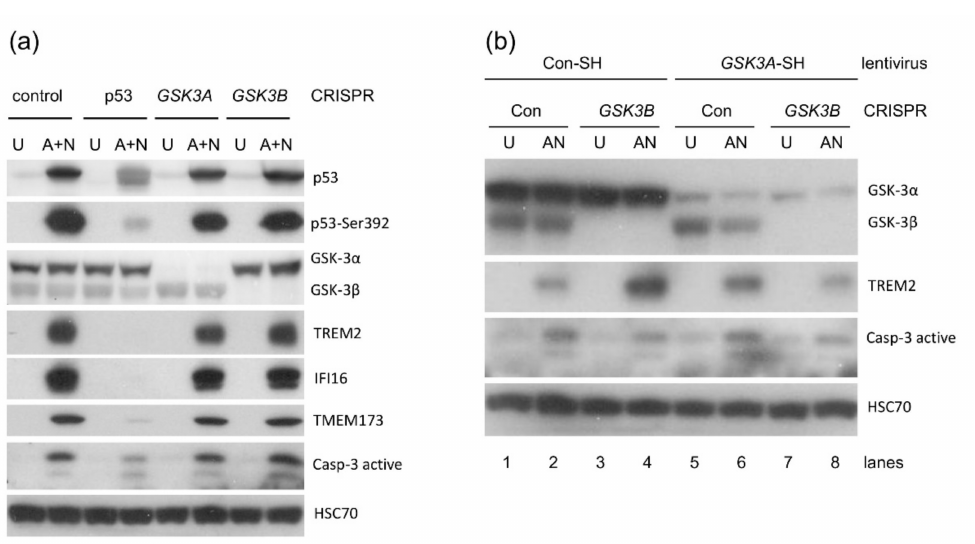
Figure 9. Downregulation of GSK-3 does not mimic the effect of CHIR-98014 on TREM2 expression or caspase-3 activation. ( a ) The expression of selected proteins in cells with the expression of either GSK-3 α , GSK-3 β or p53 downregulated by CRISPR/Cas9 technology. Control cells for knockdown were also used. The cells were either mock-treated (U) or exposed to A + N for 48 h. ( b ) Expression of TREM2 and active caspase-3 in cells with double knockdown of GSK3A and GSK3B . The cells with GSK3B expression knocked-down by CRISPR/Cas9 technology or the controls for knockdown were transduced either with lentivirus producing the shRNAs directed against GSK3A mRNA or with the control lentivirus. We obtained four cell lines as demonstrated. One of the cell lines had strong downregulation of both GSK3A and GSK3B . The cells were either mock-treated (U) or exposed to A + N for 48